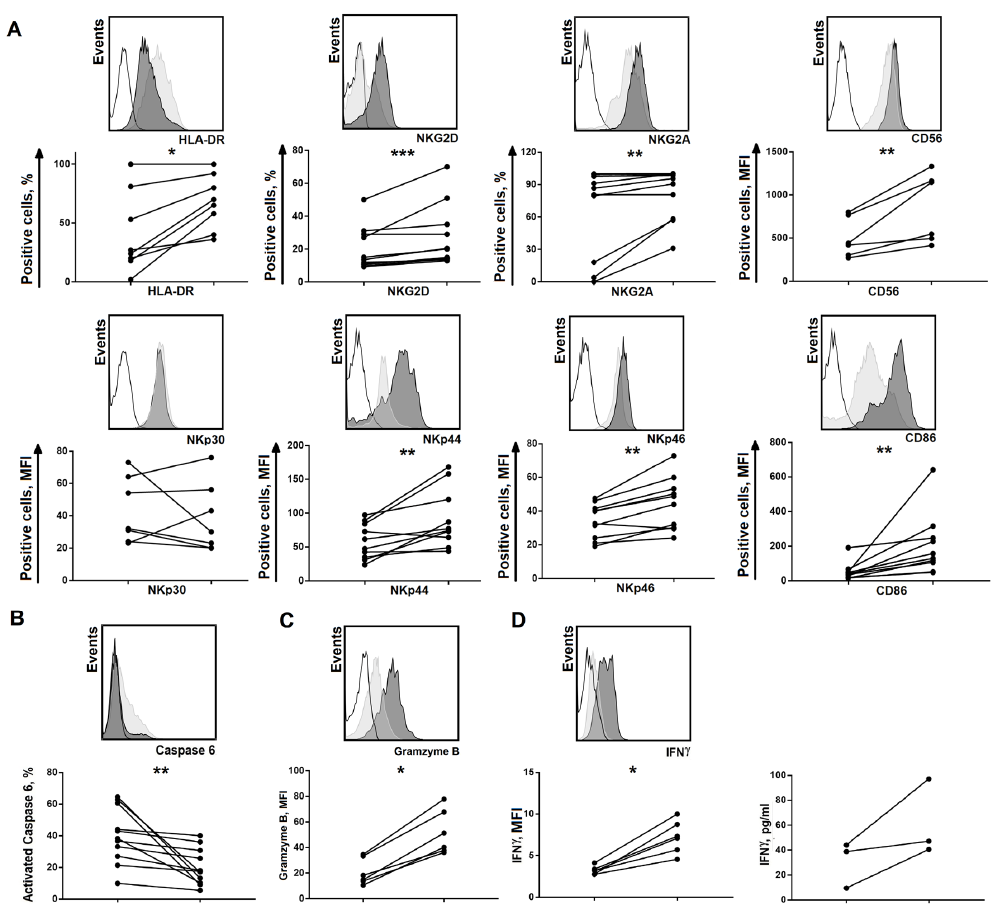
Figure 4. Phenotypic and functional analysis of NK cell clones stimulated using IL-2 with or without K562-mbIL21 feeder cells. ( A ) Phenotypic analysis of clones stimulated using IL-2 with or without K562-mbIL21 feeder cells for two weeks. The clones were divided into two equal parts after six weeks of cultivation using model 2 and then one part was restimulated with feeder K562-mbIL21 cells. Histograms show representative staining of an individual clone cultivated with (dark grey) or without K562-mbIL21 (light grey). The changes in surface markers cultured clones without (left) and with the addition of feeder cells (right). ( B ) Natural cytotoxicity of clones stimulated using IL-2 without (light grey; left) and with the addition of feeder cells (dark grey; right) measured during week four of cultivation. ( C ) Granzyme B intracellular levels in clones cultivated without (light grey; left) and in the presence of feeder cells (dark grey; right). ( D ) IFN-γ production via clones stimulated using IL-2 without (light grey; left) or with (dark grey; right) K562-mbIL21 feeder cells. Intracellular IFN-γ levels and IFN-γ concentrations in culture supernatants are presented. Wilcoxon signed rang test was used for the determination of statistical differences. Significant differences are shown by asterisks as * p < 0.05; ** p < 0.01; *** p <